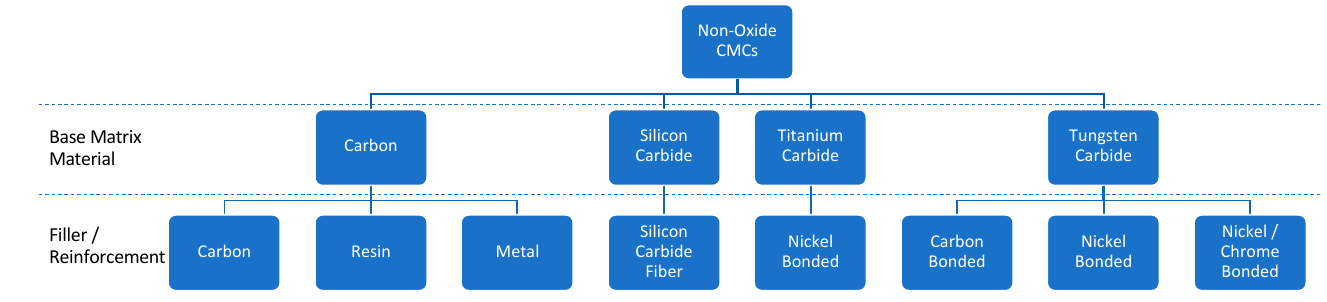
Figure 5. Non - oxide CMC material categories. Figure 5. Non-oxide CMC material